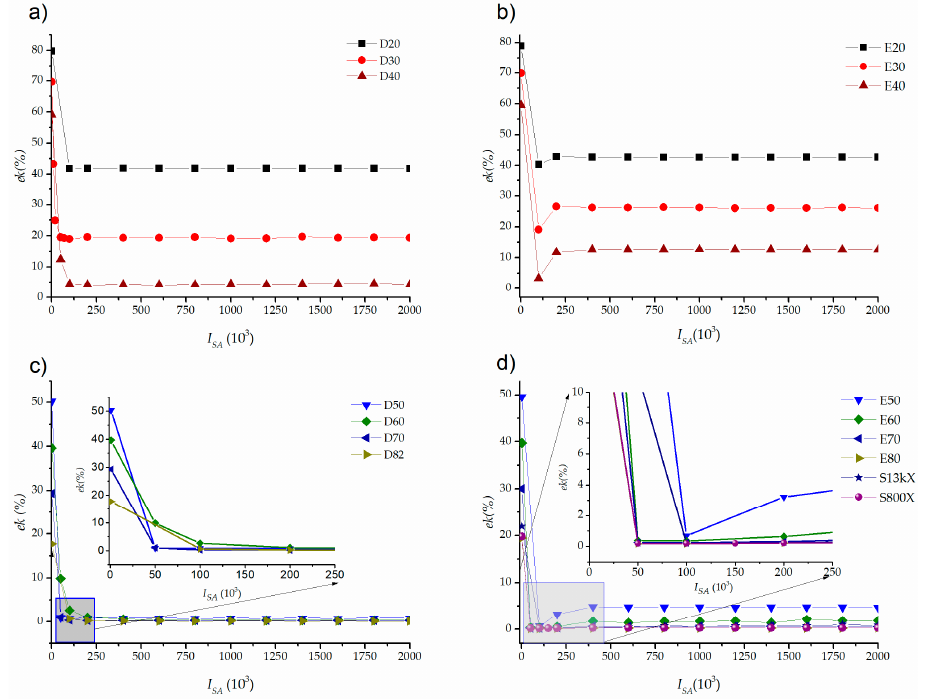
Figure 9. Average of ek (%) for the dispersion phase (j 0 ) vs. 𝐼 (cid:3020)(cid:3002) ; ( a ) systems D20–D40; ( b ) systems E20– 40; ( c ) systems D50–D82 and ( d ) systems E50–E80 and S.